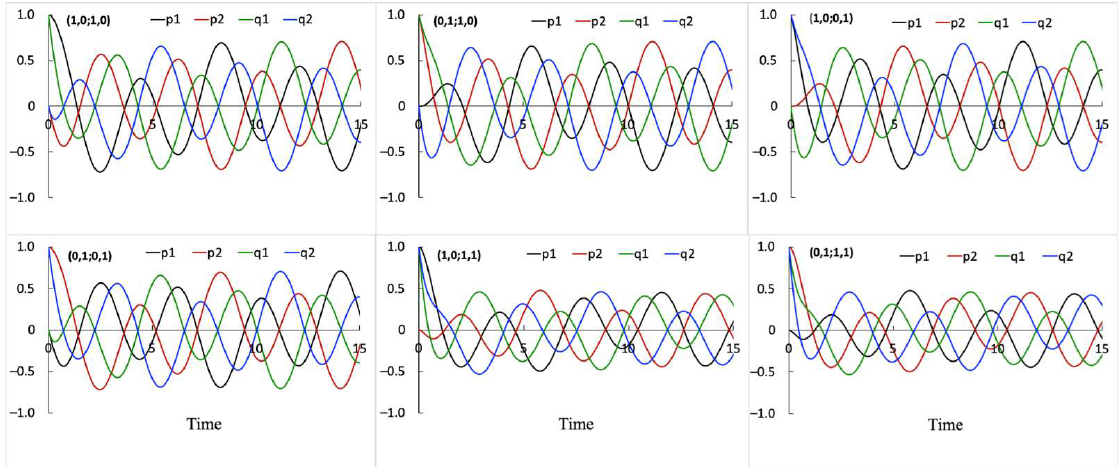
Figure 5. The change in dynamic relationships among p 1 , p 2 , q 1 , q 2 processes depend on initial conditions. Six initial conditions (i)–(vi) shown in Figure 2 are used to produce these simulation results. These conditions induce distinct dynamic relationships among processes and, thereby, can be discriminated by the system. The initial conditions are indicated in the figures as two pairs of digits corresponding to initial values of ( p 1 , p 2 ; q 1 , q 2 ) shown in parenthesis at the upper left corner of each figure panel. All simulations are obtained using the interaction scheme shown in Figure 1a and the following parameter values: ε = − 1, α = − 1.